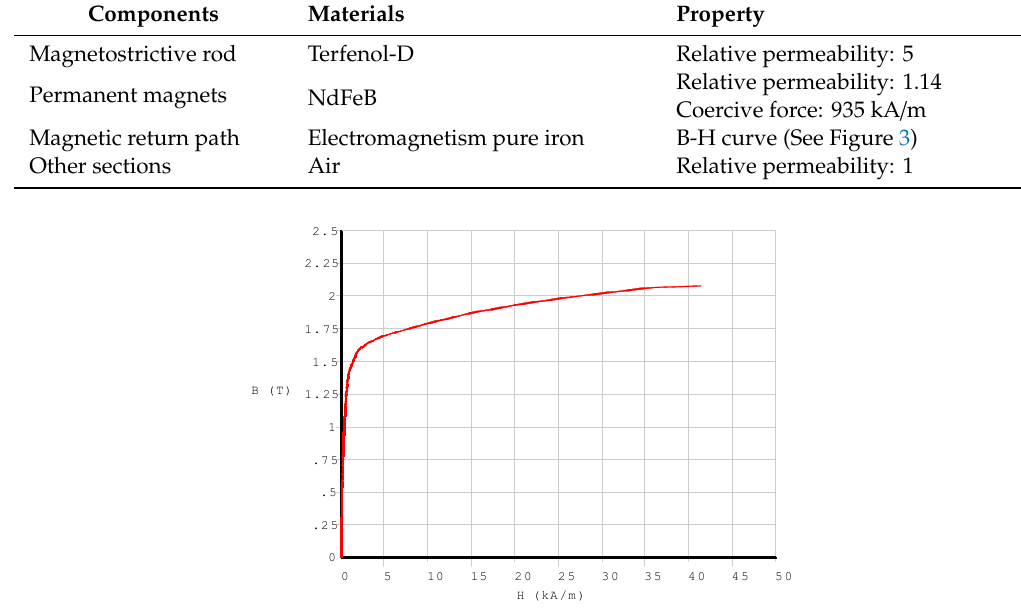
Figure 3. The nonlinear B-H curve of the electromagnetism pure iron used as magnetic return path.